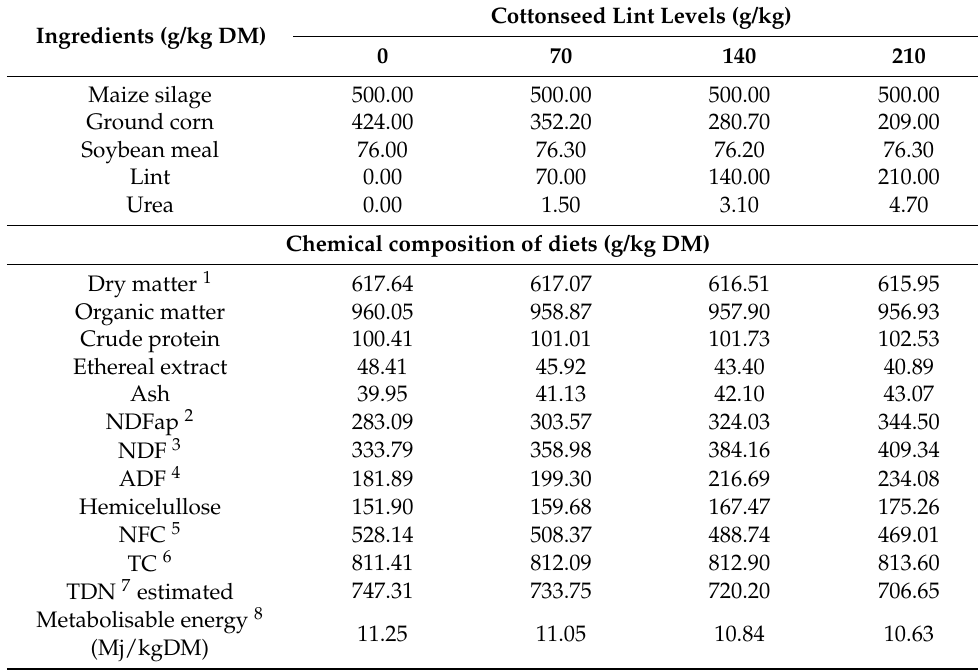
Table 3. Proportion of ingredients and chemical composition of diets with cottonseed lint levels, and average of body weight animals fed each